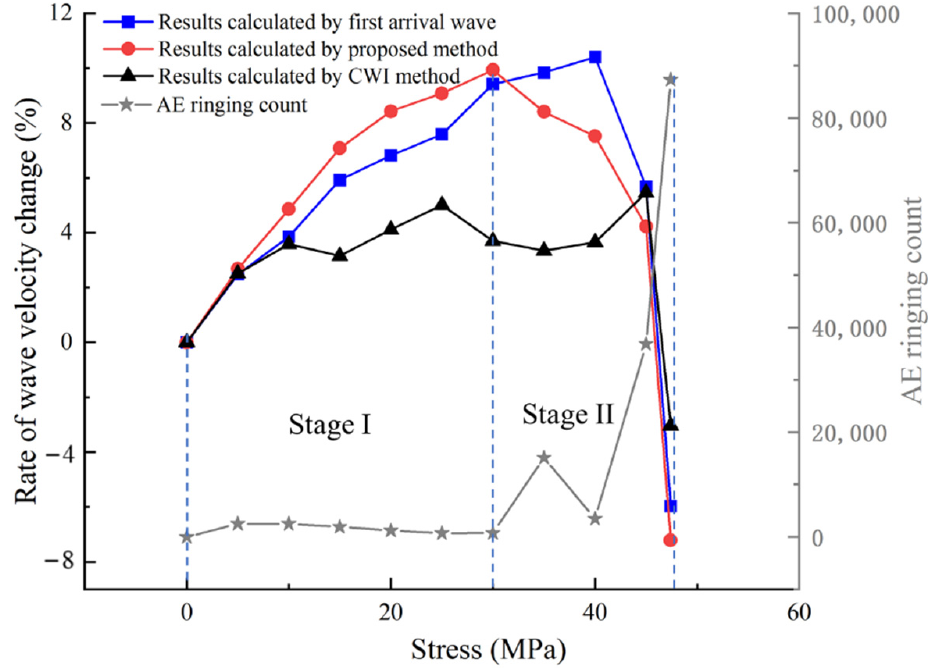
Figure 17. Results of wave velocity change calculated with different methods, and the AE ringing count during uniaxial compression.